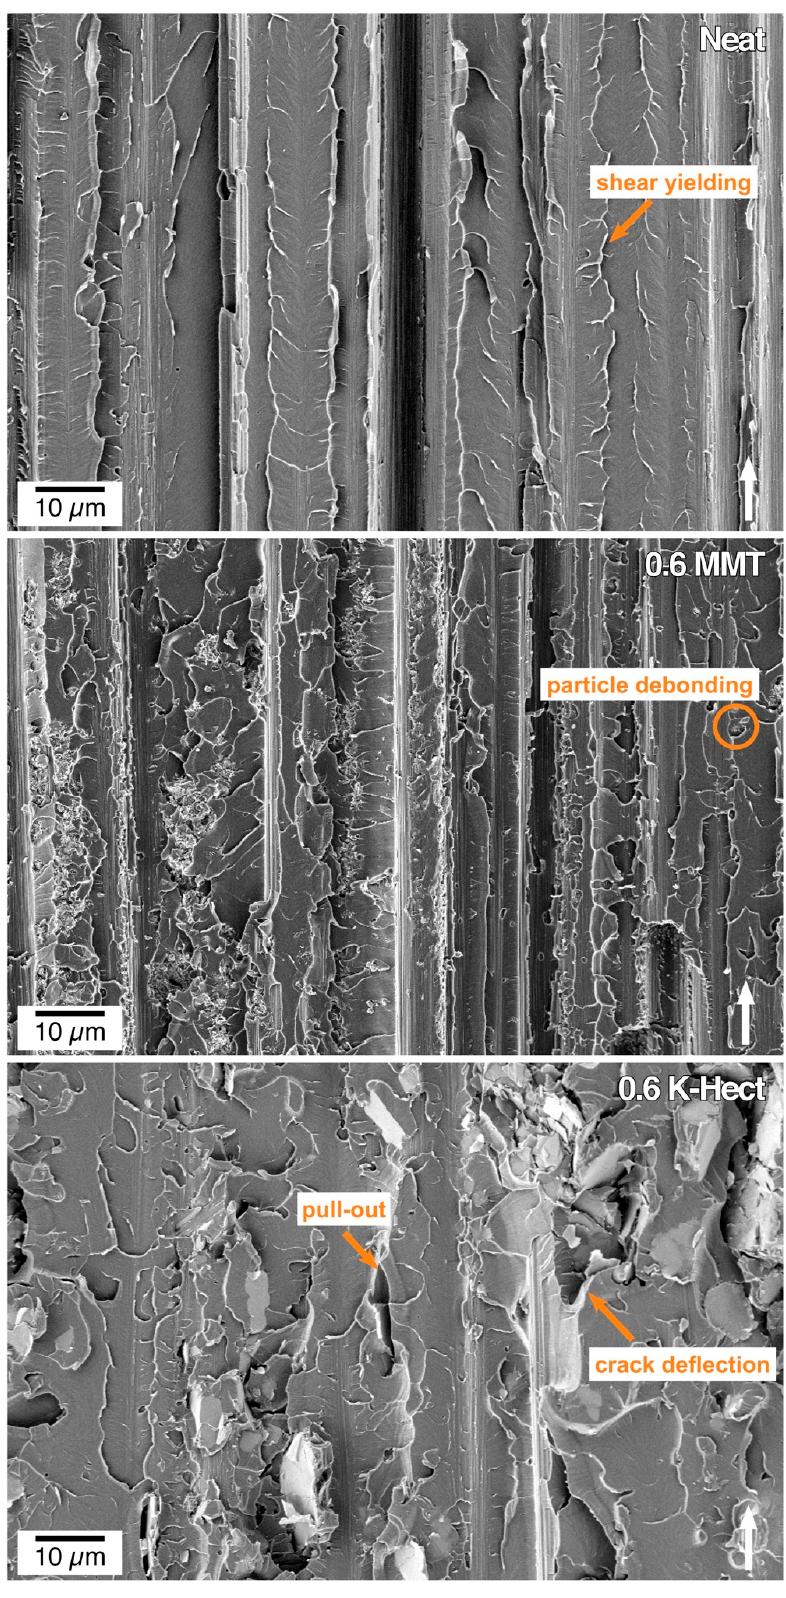
Figure 8. SEM pictures of fracture surface of double cantilever beam samples (filler content in vol % is given in pictures). The white arrow shows the direction of crack propagation.